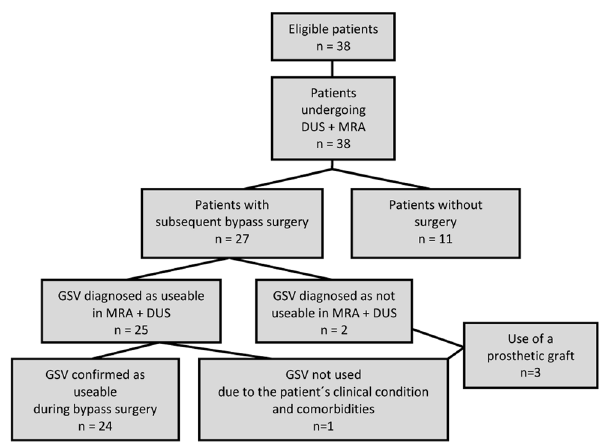
Figure 1. Flowchart portraying the study design.